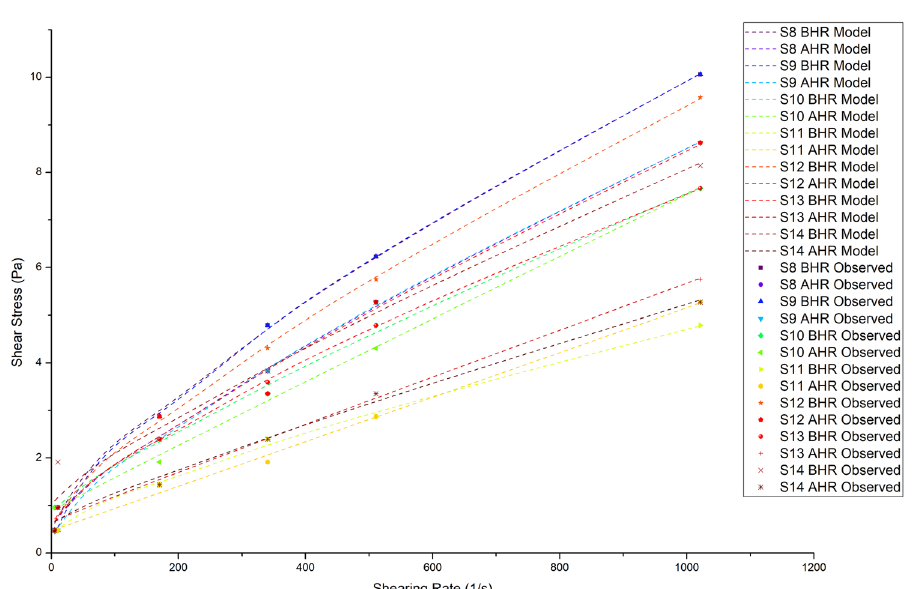
Fig. 11 Stress versus shearing rate of